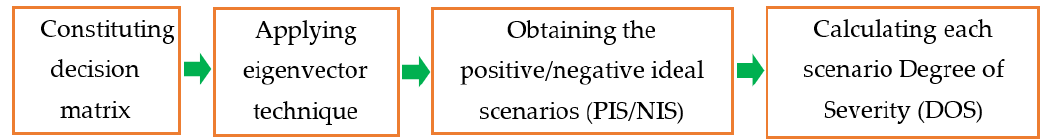
Figure 1. Calculation procedure of DOS.